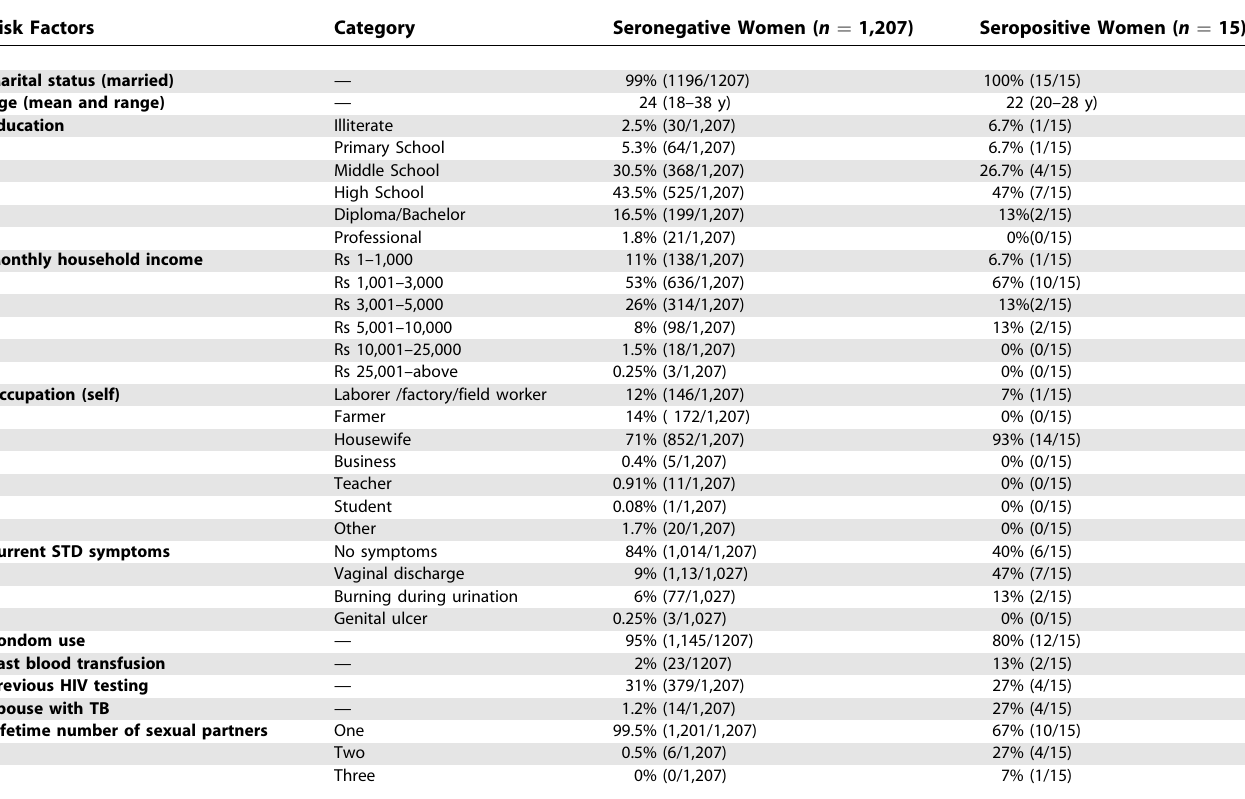
Table 1. Demographic and Risk Factors in HIV Seronegative Women and Seropositive Women Risk